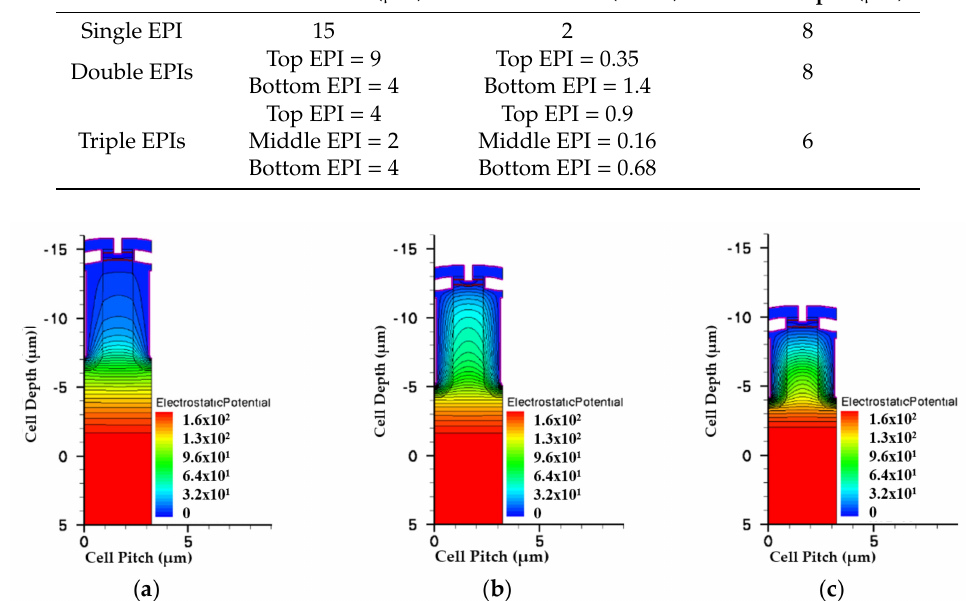
Figure 8. The simulated potentials for the split-gate trench power MOSFET with ( a ) single EPI, ( b ) double EPIs, and ( c ) triple EPIs at 150 V rating voltage. The color bars are scaled on the same degree.